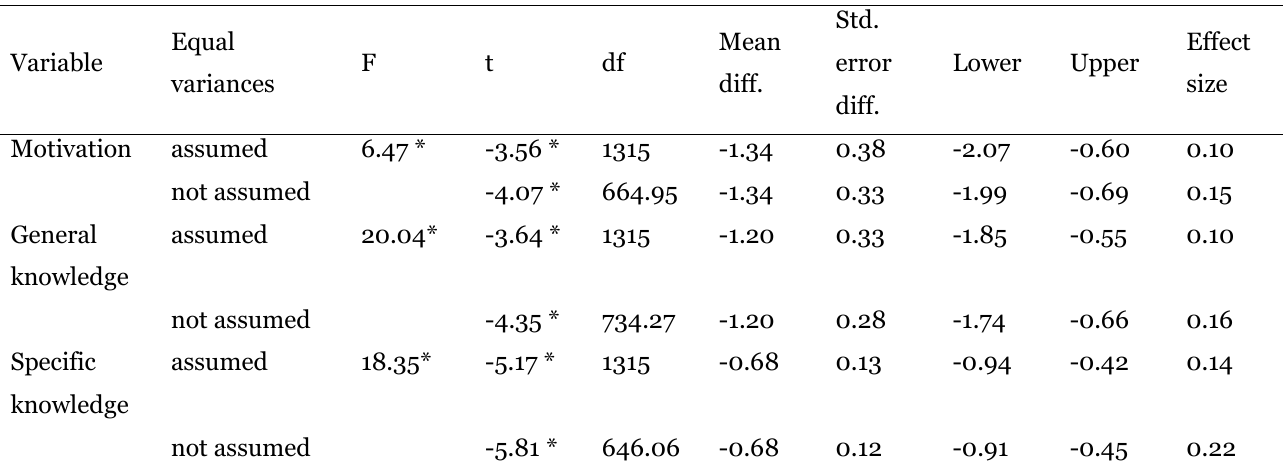
Independent Samples t-Test